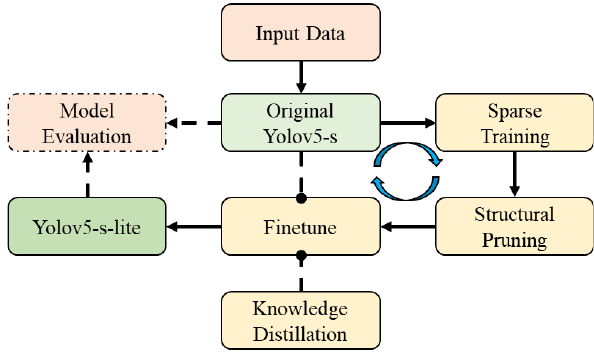
Figure 2. Process of the hybrid compression method.